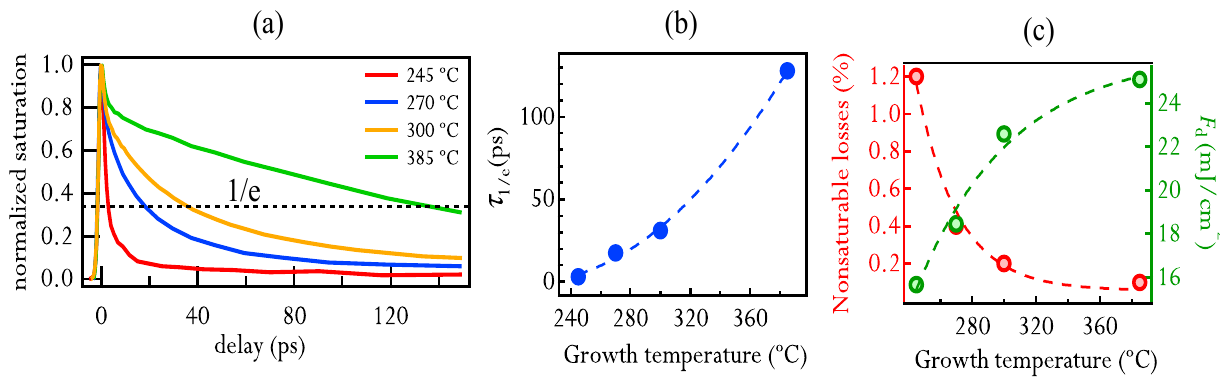
absorbers grown at different temperatures; ( b ) Dependence recovery time at 1/e on absorber growth temperature; ( c ) Dependence of damage threshold (green) and nonsaturable losses (red) on QW growth